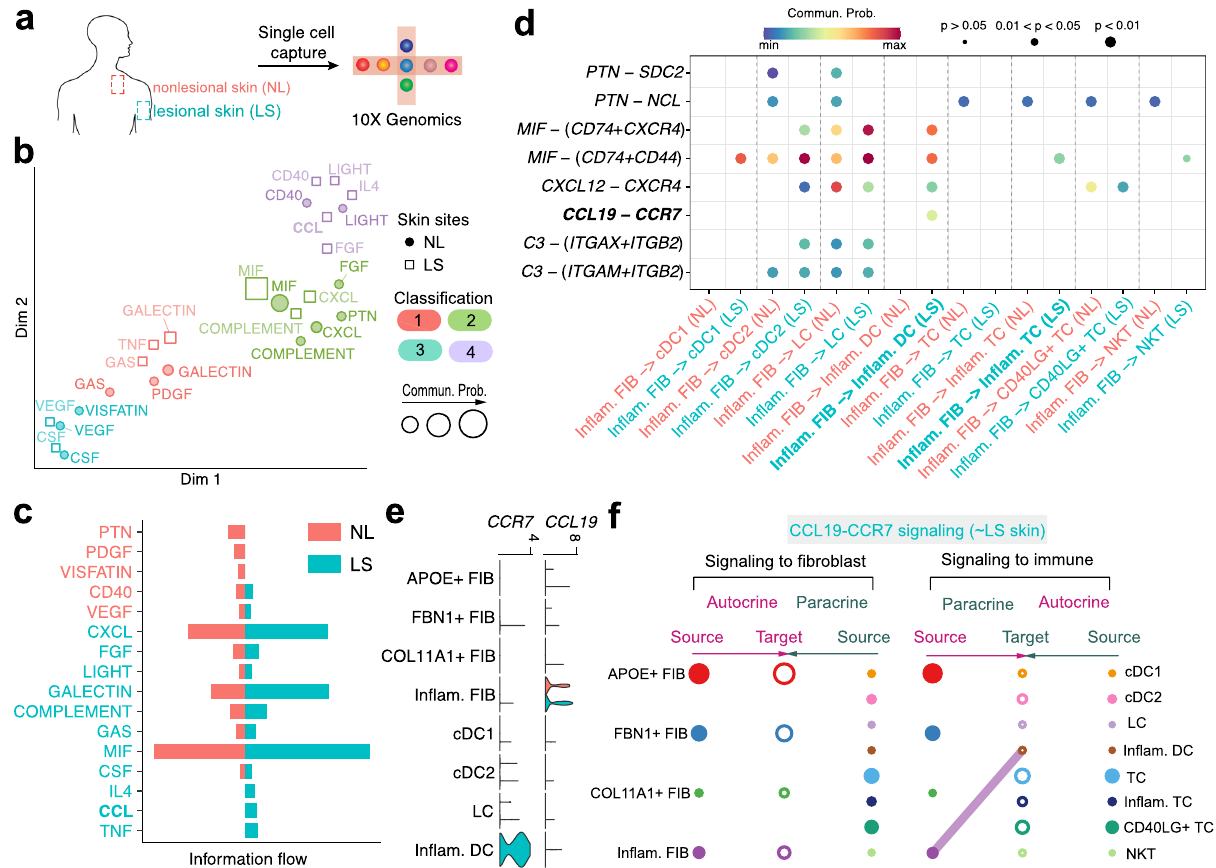
Fig. 7 Identi fi cation of major signaling changes in diseased human skin. a Schematic illustration of scRNA-seq on cells from nonlesional (NL, normal) and lesional (LS, diseased) human skin from patients with atopic dermatitis. b Jointly projecting and clustering signaling pathways from NL and LS skin onto shared two-dimensional manifold according to functional similarity of the inferred networks. Circle and square symbols represent the signaling networks from NL and LS respectively. Each dot or square represents the communication network of one signaling pathway. Dot or square size is proportional to the communication probability. Different colors represent different groups of signaling pathways. c Signi fi cant signaling pathways were ranked based on differences in the overall information fl ow within the inferred networks between NL and LS skin. The overall information fl ow of a signaling network is calculated by summarizing all communication probabilities in that network. The top signaling pathways colored red are enriched in NL skin, and these colored green were enriched in the LS skin. d Comparison of the signi fi cant ligand-receptor pairs between NL and LS skin, which contribute to the signaling from In fl am.FIB (i.e., in fl ammatory fi broblasts) to dendritic cells (DC) and T cells (TC) including cDC1, cDC2, LS, In fl am.DC, TC, In fl am.TC, CD40LG + TC, and NKT subpopulations. The highlighted CCL19-CCR7 signaling was previously validated using immuno fl uorescence staining. Dot color re fl ects communication probabilities and dot size represents computed p-values. Empty space means the communication probability is zero. p -values are computed from one-sided permutation test. e Expression distribution of ligand CCL19 and its receptor CCR7 in NL (red) and LS (green) skin. f Hierarchical plot showing inferred intercellular communication network of CCL19-CCR7 signaling in LS skin. Left and right portions show autocrine and paracrine signaling to fi broblast and immune cells, respectively. Circle sizes are proportional to the number of cells in each cell group and edge width represents the communication probability. Note that CellChat predicted no signi fi cant CCL19-CCR7 signaling in NL skin. FIB: fi broblasts; In fl am.FIB: in fl ammatory fi broblasts; cDC: conventional dendritic cell; In fl am.DC: in fl ammatory dendritic cell; LC: Langerhans cell; TC: T cell; In fl am.TC: in fl ammatory T cell; NKT: natural killer T